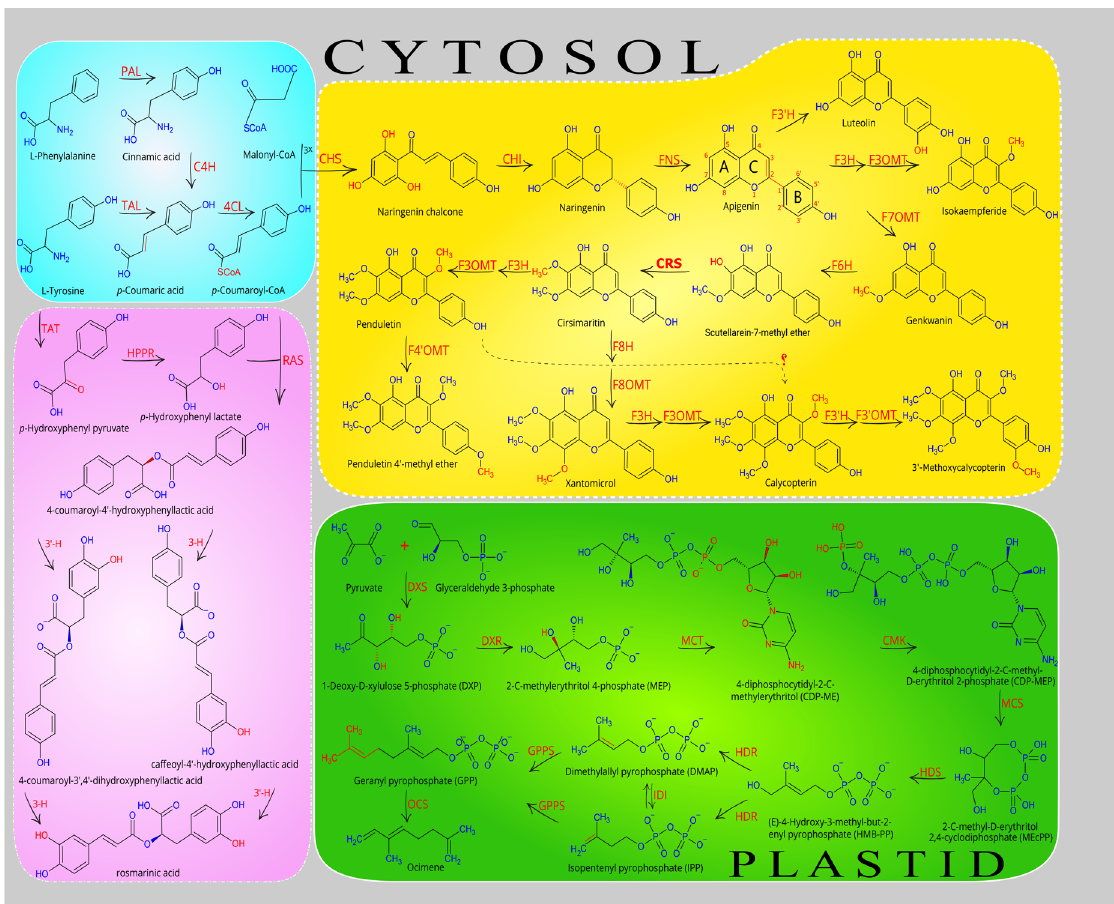
Figure 1. Proposed pathway for biosynthesis of valuable compounds in D. kotschyi . Include Xanthomicrol, Calycopterin, and Penduletin (yellow box), Rosmarinic acid (purple box), and MEP pathway for terpenoids (green box). Enzyme abbreviations: PAL, phenylalanine ammonia-lyase; C4H, cinnamate 4-hydroxylase; 4CL, 4-coumarate: CoA ligase; CHS, chalcone synthase; CHI, chalcone isomerase; FNS, flavone synthase; F3H, flavanone 3-hydroxylase; F3 ʹ H, flavonoid 3 ʹ -hydroxylase; F6H, flavonoid 6-hydroxylase; F3OMT, flavonoid 3-O-methyltransferases; F4 ʹ OMT, flavonoid 4 ʹ -O-methyltransferases; F3 ʹ OMT, flavonoid 3 ʹ -O- methyltransferases; F6OMT, flavonoid 6-O-methyltransferases or CRS, cirsimaritin synthase; F7OMT, flavonoid 7-O-methyltransferases; F8OMT, flavonoid 8-O-methyltransferases; HPPR, hydroxy phenylpyruvate reductase; TAT, tyrosine aminotransferase; RAS, rosmarinic acid synthase; TAL, tyrosine ammonia-lyase; DXS, 1-deoxy- D-xylulose-5-phosphate synthase; DXR, 1-deoxy-D-xylulose-5-phosphate reductoisomerase; MCT, 2-C-methyl- D-erythritol-4-(cytidyl-5-diphosphate) transferase ; CMK, 4-cytidine 5’-diphospho-2-C-methyl-D-erythritol kinase ; MCS, 2-C-methyl-D-erythritol-2,4-cyclodiphosphate synthase ; HDS, Hydroxy-2-methyl-2-(E)-butenyl 4-diphosphate synthase ; HDR, Hydroxy-2-methyl-2-(E)-butenyl 4-diphosphate reductase ; IDI, Isopentenyl diphosphate isomerase ; GPPS, Geranylgeranyl diphosphate synthase; OCS, Ocimene synthase. The proposed pathways were constructed by combining the literature review 13–15 , our experimental data, and bioinformatics data analysis. The final figure was created by Inkscape (1.0.2, https:// inksc ape. of DkF3OMT , DkRAS , and DkCRS genes in the leaf (10.5, 6.8, and 6.6 respectively) and bud tissues (12.8, 9.8, and 10.4 respectively) was higher than those in the flower tissue. In addition, the expression of DkF3H and DkF3OMT genes in the leaf (1.9 for each gene) and bud tissues (4.7 and 5.1 respectively) was lower than those in the flower tissue. Relative expression analysis of candidate genes in the bud tissue to the leaf tissue showed that DkF7OMT had the higher expression and DkF3OMT had the lower expression in bud tissue (Fig. 3C). Flavonoids and methoxylated flavones contents. Initially, the correlation coefficients ( R 2 ) were cal- culated for all standards of compounds, which were about 0.99 (Supplementary Fig. 15). The chromatograms of HPLC peaks relevant to the standard of each metabolite in different tissues are shown in Fig. S16 and Fig. 4A. These results demonstrate the accumulation pattern and RT for each compound at 280 nm. As shown in Fig. 4B, the flavonoids contents varied among the different organs and tissues. In general, all of the measured metabo- lites had a higher amount in the mixture of flowers and buds and flower tissue. Calycopterin had a significant amount in leaf tissue (15.98 mg/g DW). After that, a high quantity of penduletin (9.30 mg/g DW) was achieved